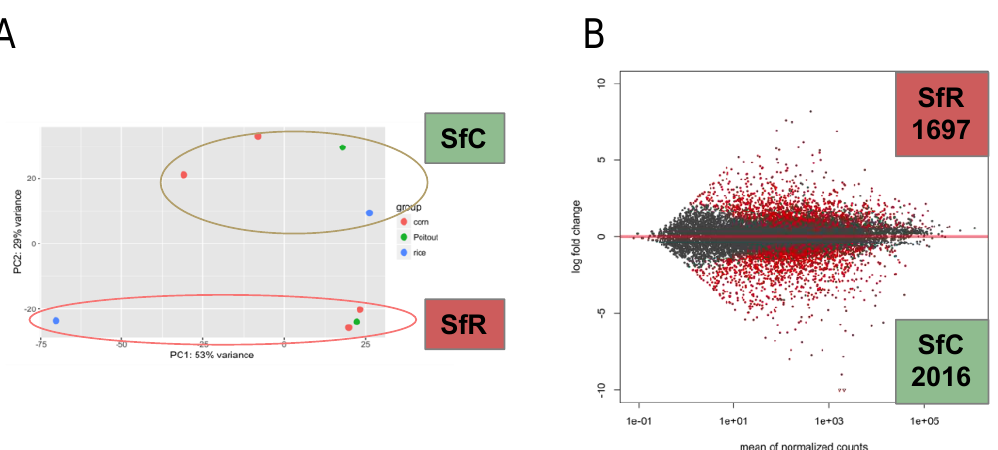
Figure 3: Transcriptional response of sf-R versus sf-C regardless of the diet. (A) Principal component analysis on normalized RNA-seq reads for all RT samples of sf-R and sf-C when the larvae feed on corn (red), on rice (blue) or on artificial diet (green). (B) Multidimensional scaling plot (MA-plot) reporting the log2 fold changes between the strains (sf-R vs sf-C) over the mean of normalized counts. Each dot represents a gene either with a non-significant differential expression between trials (gray dots) or with a significant differential of expression (red